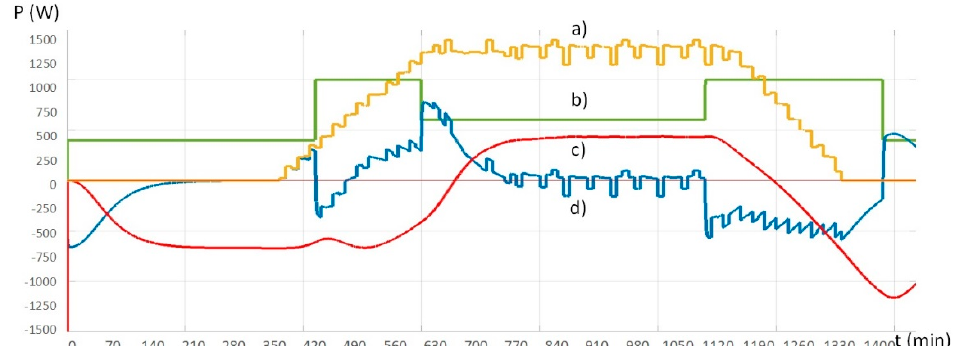
Figure 14. Simulation process for sunny day conditions. Storage system filter with damping ratio ζ = 0.5: ( a ) the PV plant production, ( b ) the power required by the consumer, ( c ) the battery storage power and ( d ) the supercapacitor